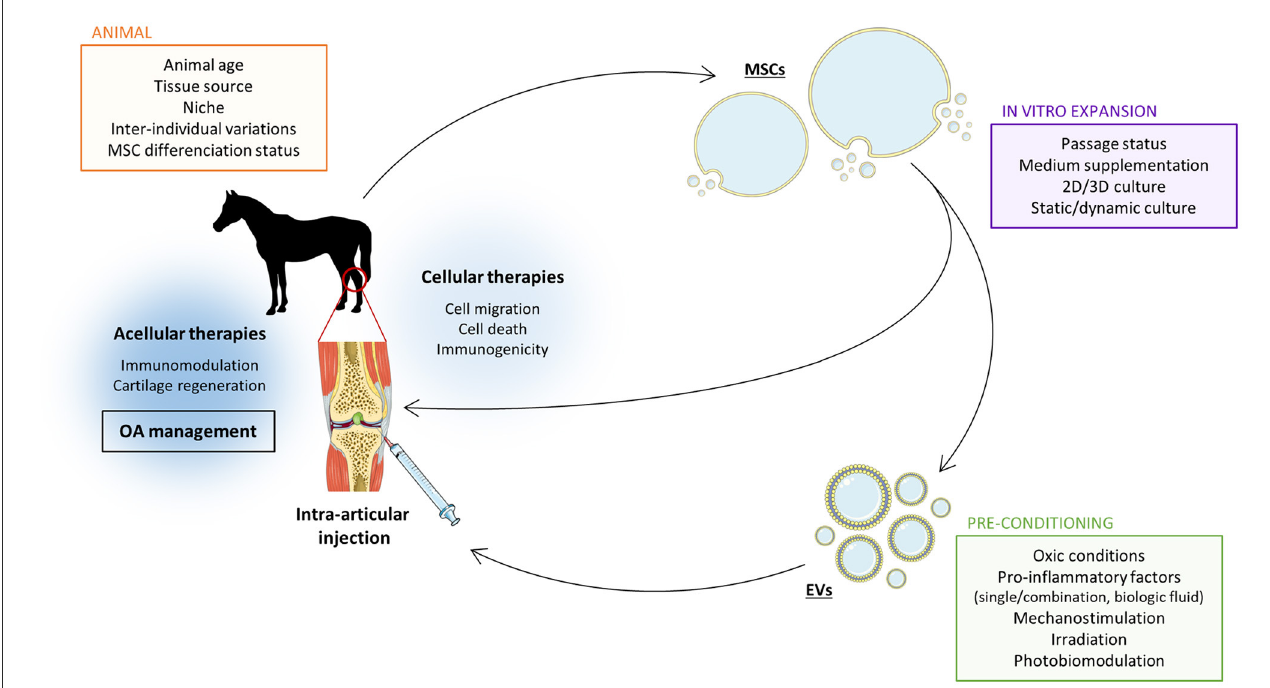
FIGURE2 Several parameters must be considered to improve the therapeutic potential of MSC-derived EVs in the treatment of equine OA. Mesenchymal stromal cells (MSC)-derived extracellular vesicles (EVs) have the capacity to improve equine osteoarthritis (OA) management via immunomodulation and stimulation of cartilage matrix synthesis. However, this therapeutic potential can be enhanced by adjusting the steps in the EV production protocol. The source of MSCs affects EV properties and their therapeutic capacities. The MSC culture methods can be used as a tool to optimize the therapeutic effect of MSC-derived EVs. In the last years, it has been demonstrated that EV properties can be refined by adjusting oxic conditions, adding pro-inflammatory cytokines or other physical parameters such as mechanical stress or light exposition. Setting the balance between all these factors is crucial to achieve the most effective therapeutic effect of MCS-derived EVs for equine OA. Moreover, acellular therapy has the advantage to avoid most of direct MSC intra-articular injections concerns such as immunogenicity. The Figure was partly generated using Servier Medical Art, provided by Servier, licensed